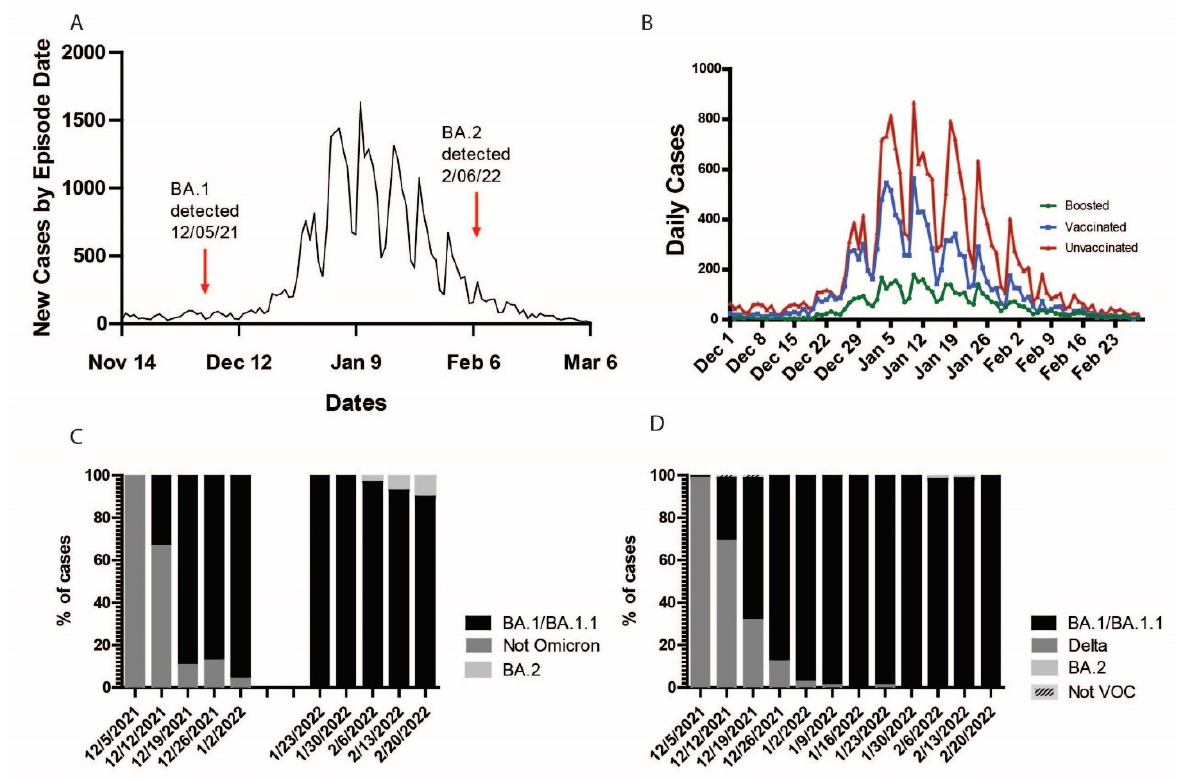
Figure 4. Daily cases and relative variant proportions in Santa Barbara County. ( A ) Total new COVID-19 cases by episode date and ( B ) new cases in boosted, vaccinated, and unvaccinated individuals in Santa Barbara County reported by the SBCPHD [42]. ( C ) Relative proportion of omicron samples in Santa Barbara County, determined via variant-specific RT-qPCR and ( D ) whole viral NGS.